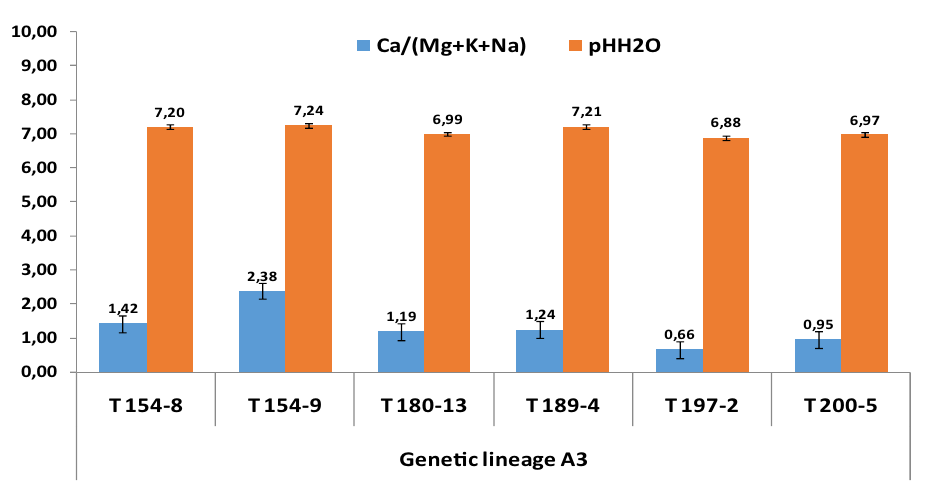
Figure 6. Singular site specific index of active forms of alkaline elements (Ca, Mg, K, Na) and pH in the growth media of A. pinguis cryptic species A genetic lineage A3 at Tatry